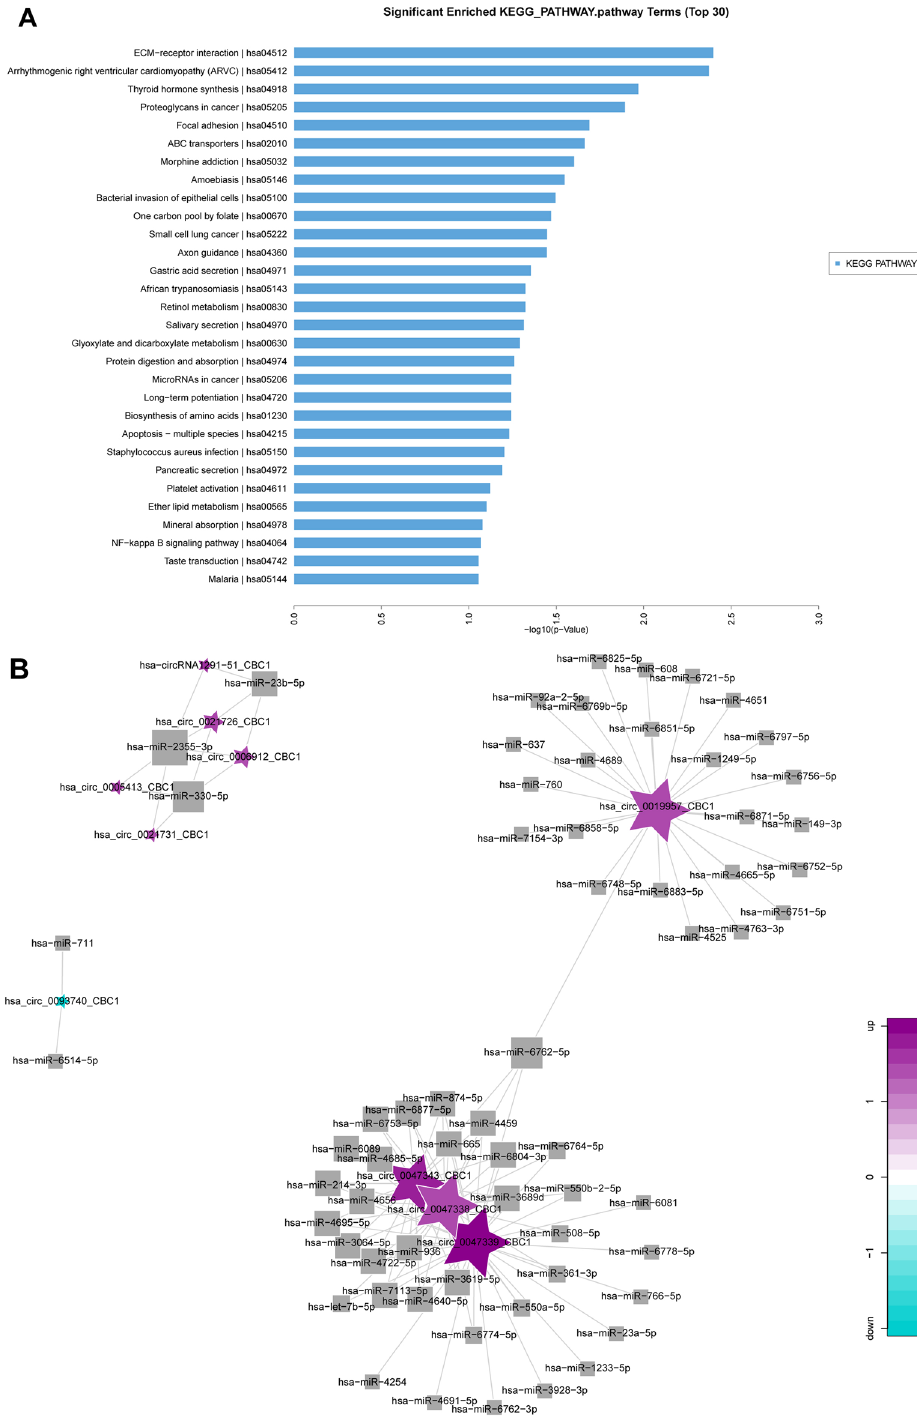
Figure 2. Interaction between circRNA and miRNA in urethral scar tissue. ( A ) KEGG showed the enrichment of differential circRNA functional pathways. ( B ) CircRNA–miRNA interaction analysis network diagram. Square represented miRNA, and pentagram represented circRNA, in which green was down-regulated and purple was upregulated. The size of a point meant the number of nodes connected to the point, and the larger the point, the more nodes connected to the